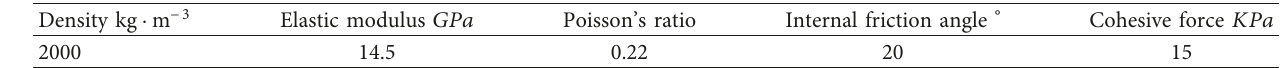
Table 2: The physical and mechanical parameters of the rock.